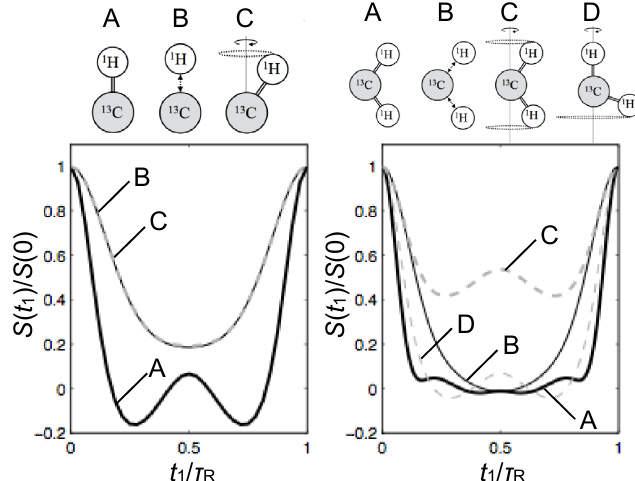
Figure 11. Effect of C–H motion on a DIPSHIFT curve for CH and CH 2 groups. The effect is modeled by assuming uniaxially symmetric motion of the C–H bonds as indicated in the sketches and compared with the rigid cases A and B (left and right). For both CH and CH 2 , case B (no rotational motion) has the same dipolar coupling magnitude as case C (covalent bonds with rotational motion) by moving the proton away by the required